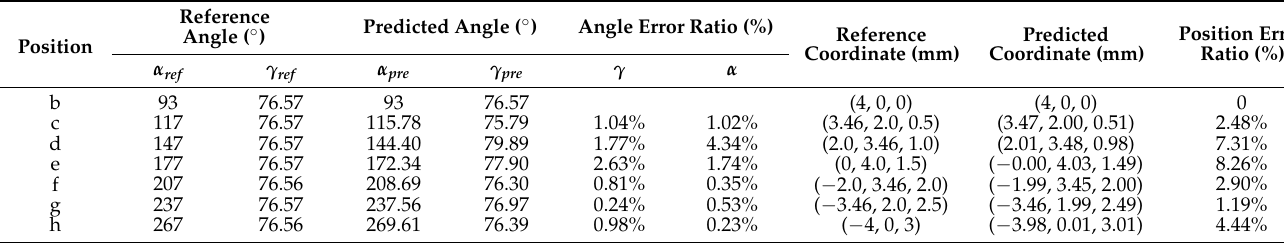
Figure 10. Path tracking of magnetic microrobot by RBFNN: ( a ) simulation results of path tracking by MNNC-based RBFNN; ( b – h ) show the rotating plan of the magnetic field and the movement direction at different positions of the path, and the coil current of X , Y , and Z -axis in one cycle; the rotating frequency of magnetic field is 1 Hz. For improved visualization of the parameters, the view angle for each figure is different. Table 5. Path tracking error ratio of position